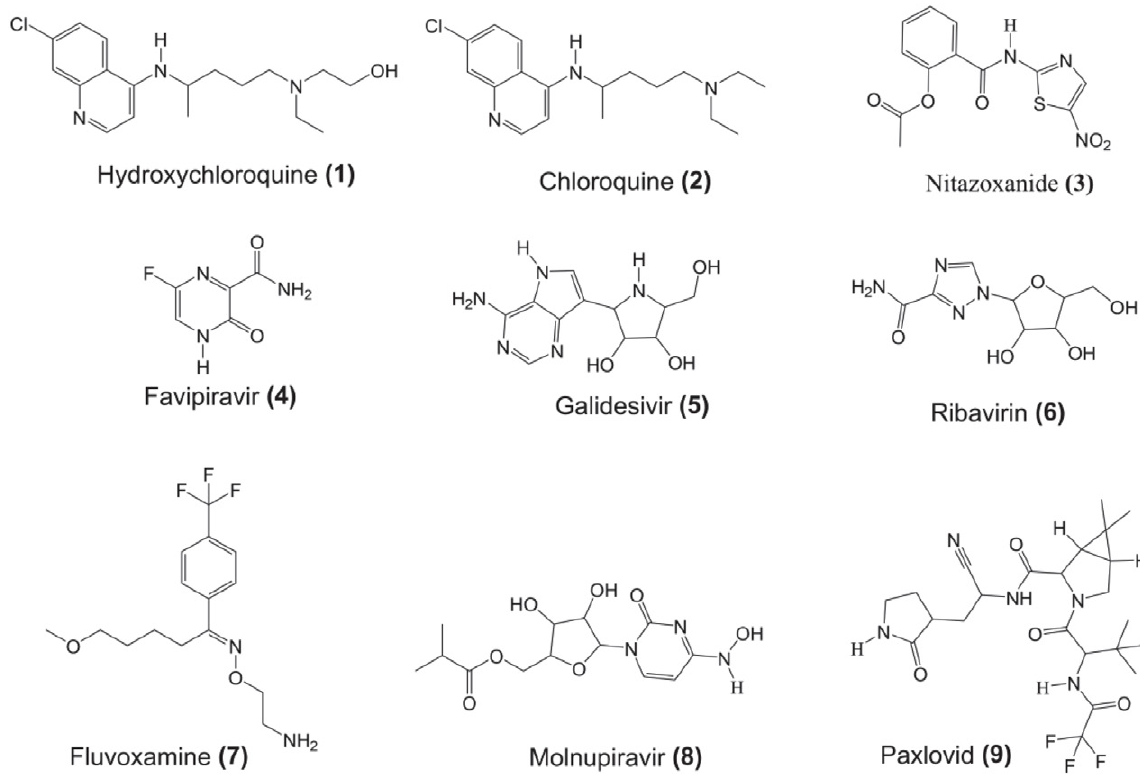
Figure 1. Structures of drug